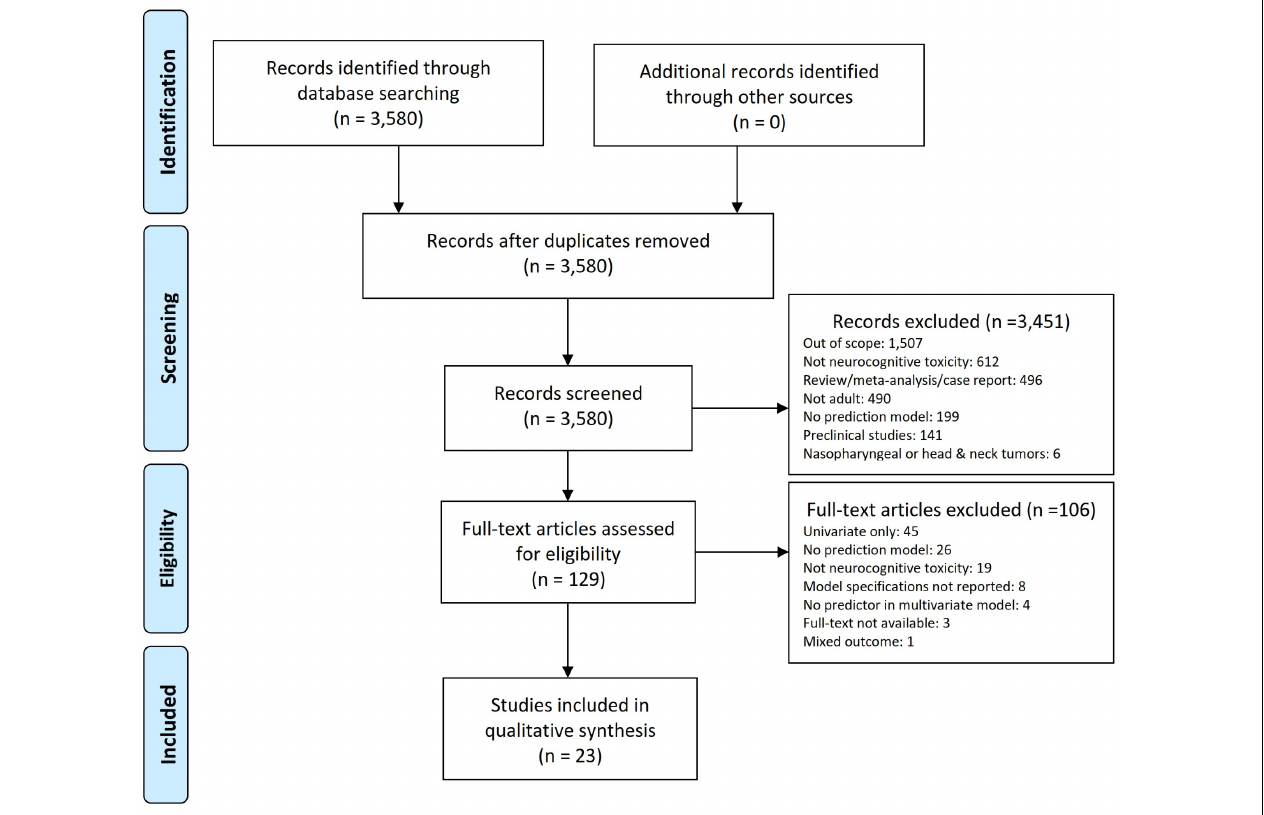
FIGURE 1 | PRISMA flow diagram for inclusion and exclusion of